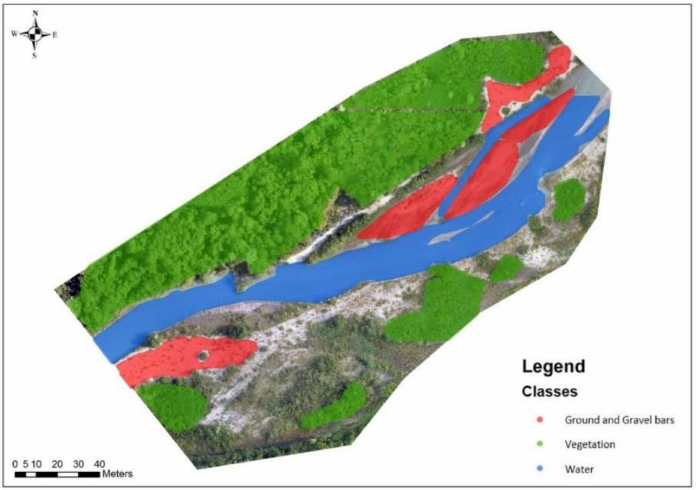
Figure 5. Training ROIs selection: water in blue, vegetation in green, and ground/gravel bars in